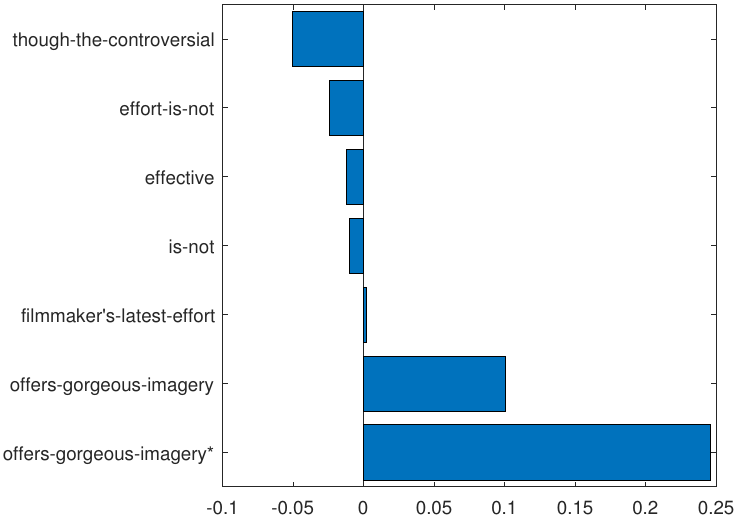
Figure 12. N-grams determined from R 24 and the following “tweet”: “though the controversial korean filmmaker’s latest effort is not for all tastes, it offers gorgeous imagery, effective performances, and an increasingly unsettling sense of foreboding.” The sum of the n-grams linear contributions is 0.251.